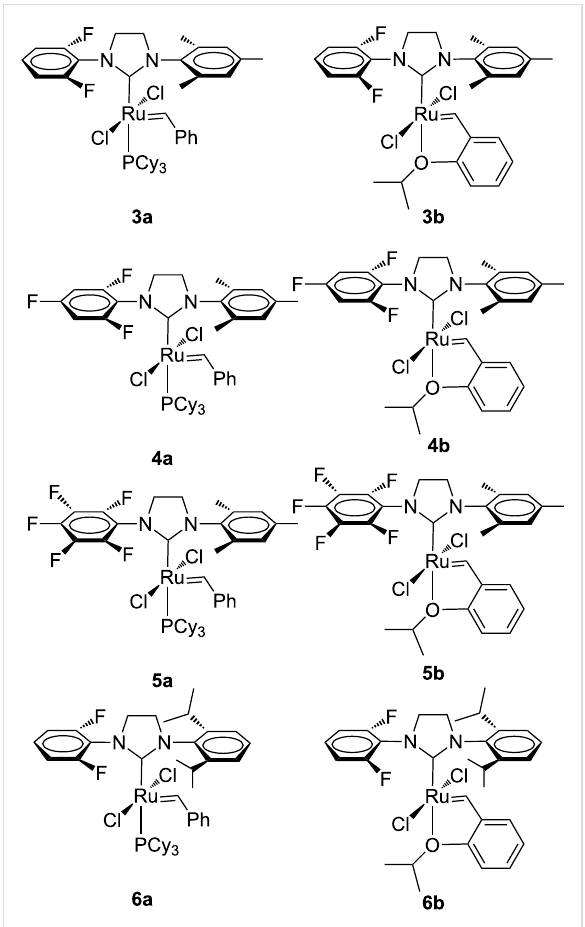
Figure 4: Grubbs ( 3a – 6a ) and Hoveyda-type ( 3b – 6b ) complexes with N -fluorophenyl, N’ -aryl NHCs.